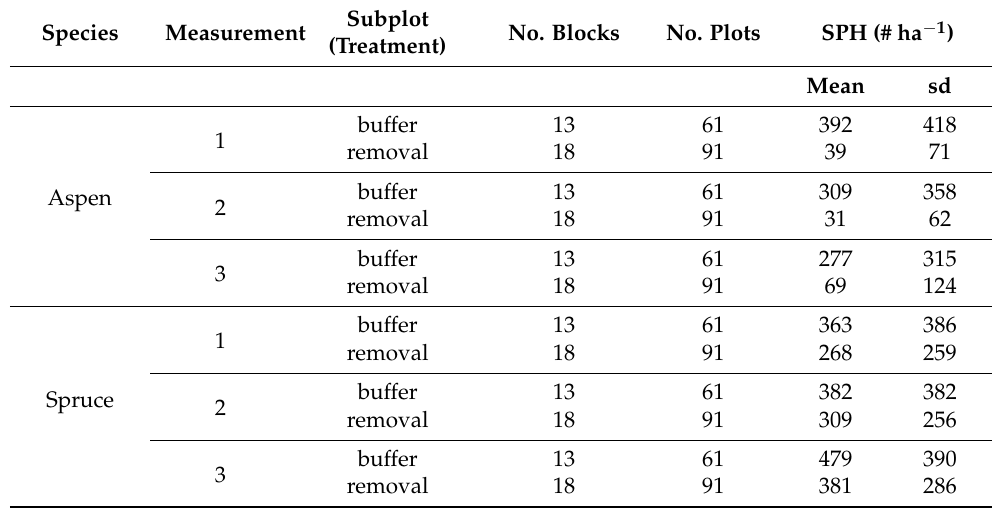
Table 5. Stand density (SPH) per subplot for aspen and spruce (trees ≥ 7.1 cm DBH) over the three measurements.